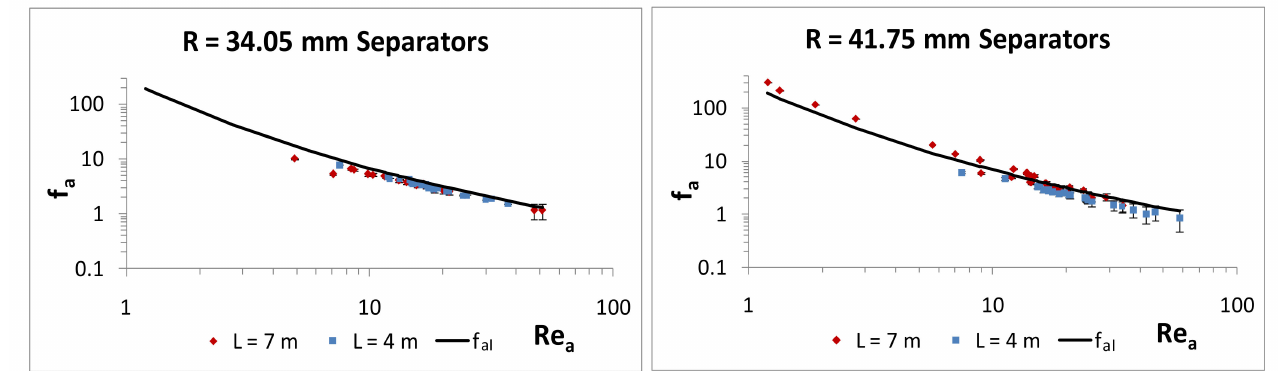
Figure 8. Relationship between the apparent Reynolds number Re a and the friction factors f aI and f a for the separators tested with different helix radiuses R (34.05 mm and 41.75 mm) and tube lengths L (4 and 7